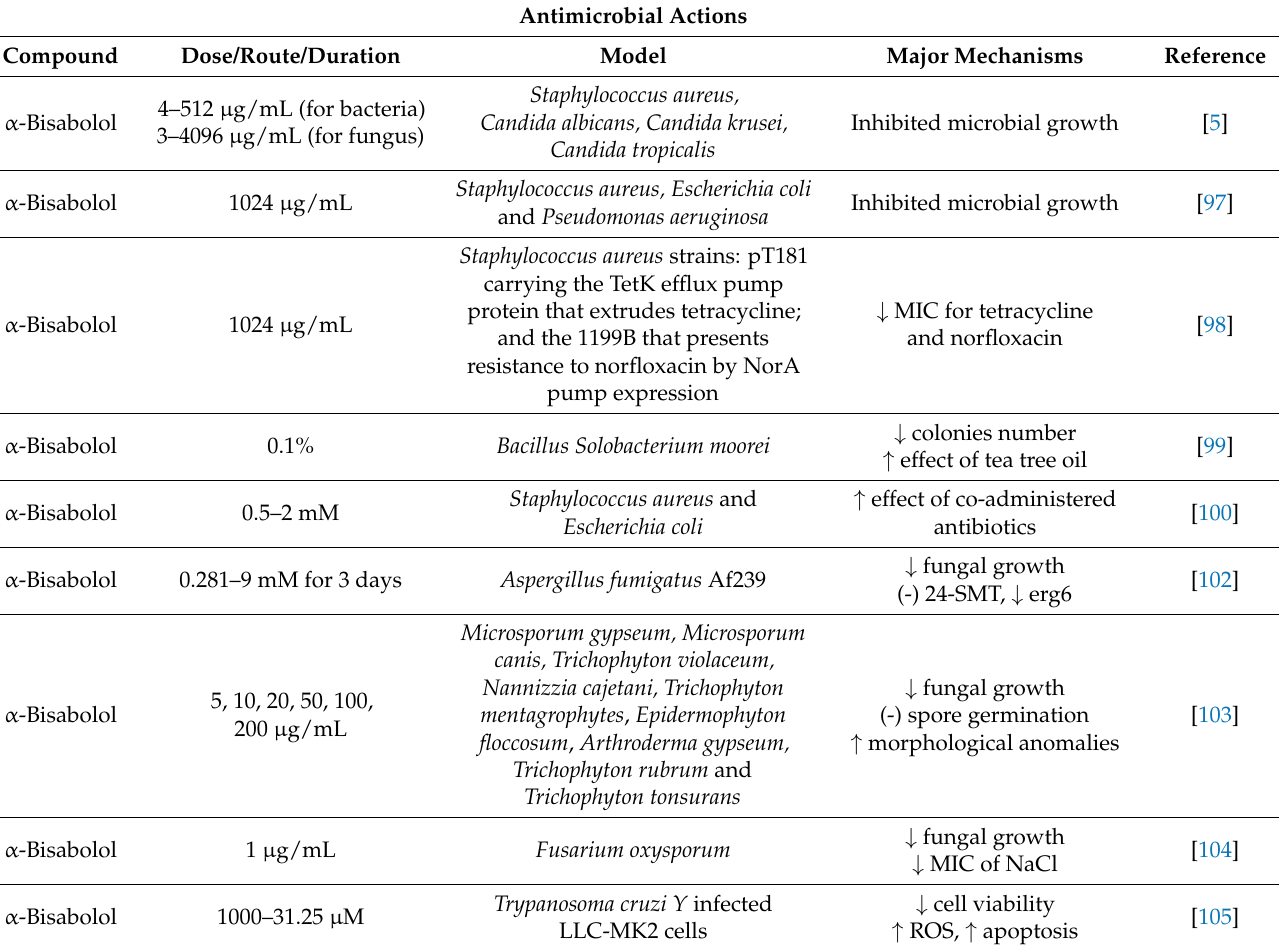
Table 8. The antimicrobial actions of α -Bisabolol against different bacterial strains. Antimicrobial